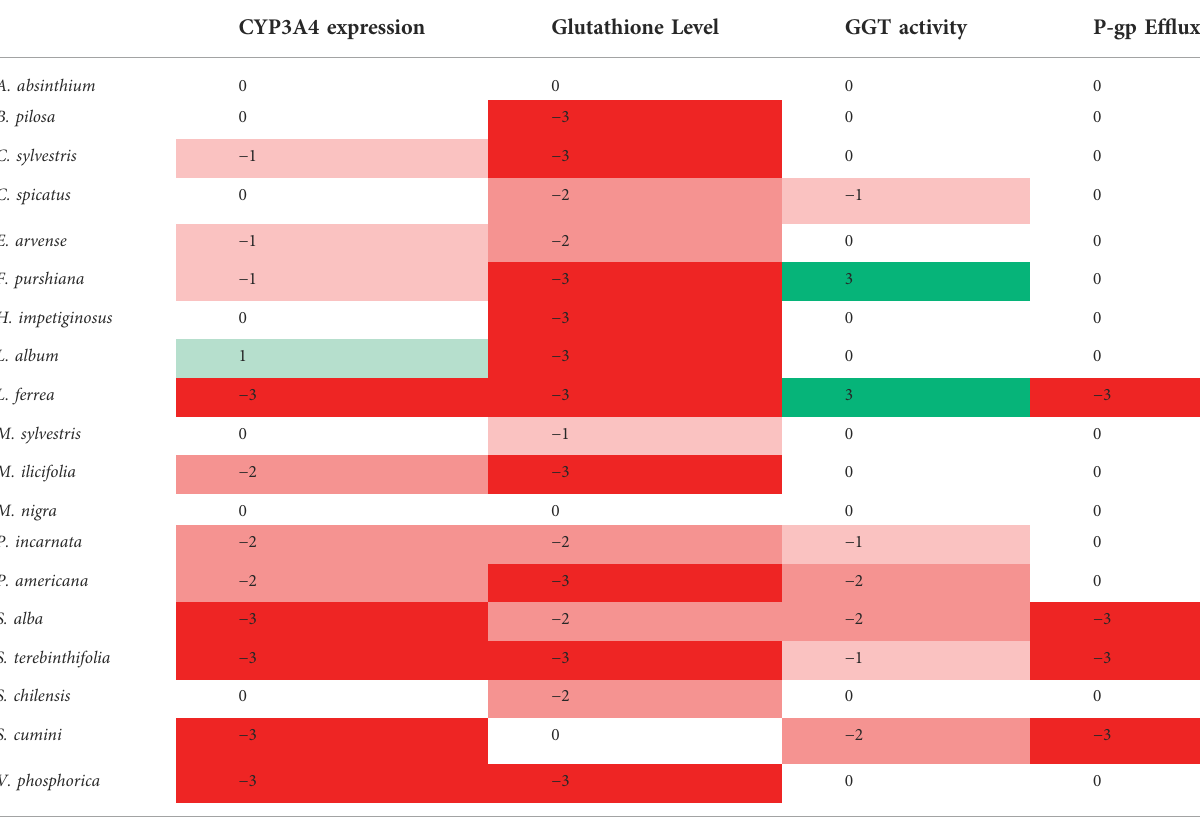
TABLE 3 Summary of the effects/activityof the selected herbalpreparations on the studied pharmacokinetic targets.This “ Heat map ” is based on the signi fi canceofeithertheinhibition (redshades)or enhancement (greenshades)ofthe measuredendpoint foreachherbalpreparationaccording to Bonferroni Post-ANOVA